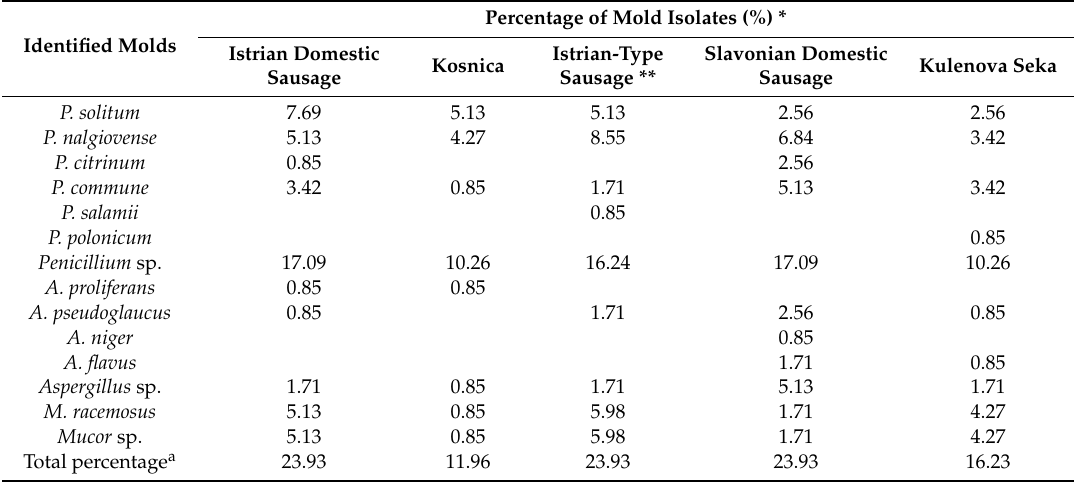
Table 2. Superficial mycobiota found on Croatian traditional dry-fermented